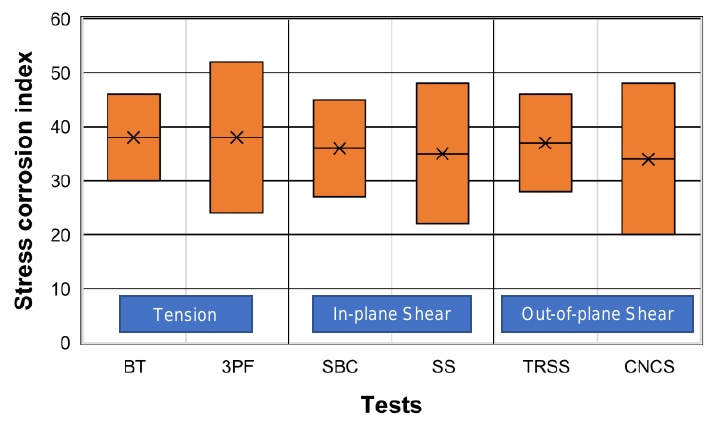
Figure 17. Variation in stress corrosion index. Table 2. Stress corrosion indices for di ff erent rock